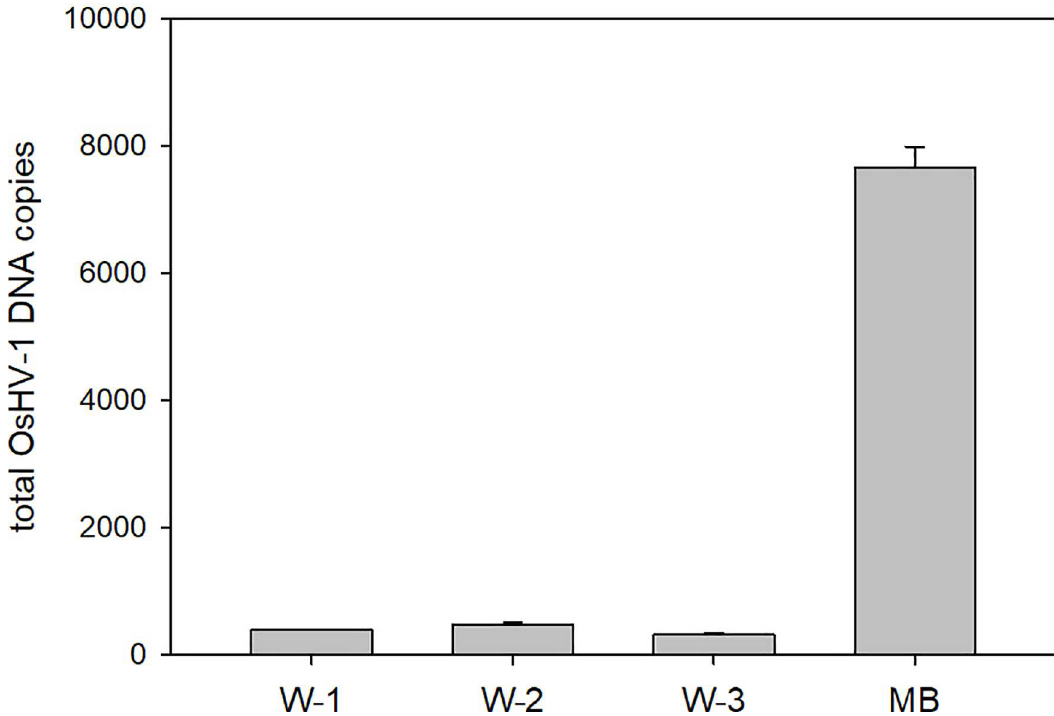
Fig 2. OsHV-1 DNA detected in the supernatant after the first (W-1), second (W-2) and third (W-3) washing steps and in the MB-virus conjugates from homogenate (MB).